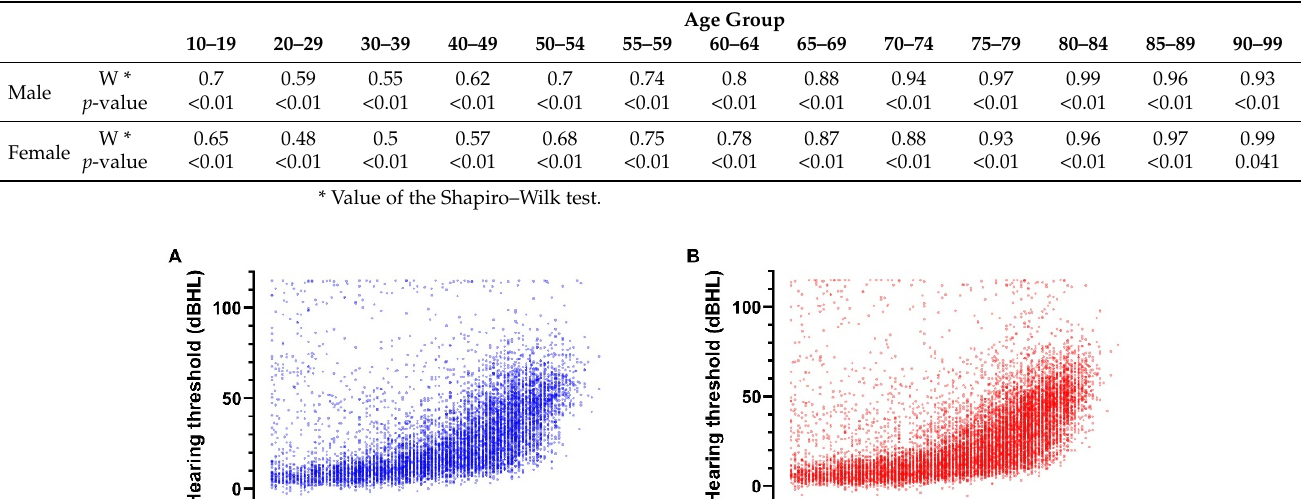
Table 3. Results of the Shapiro–Wilk test for assessing the normality of hearing threshold distributions.